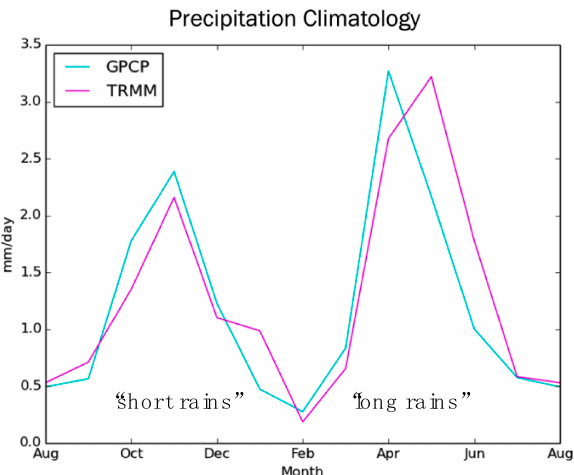
Figure 2. The climatology of rainfall over the drought region as presented by the two precipitation products used in this study, GPCP and TRMM.